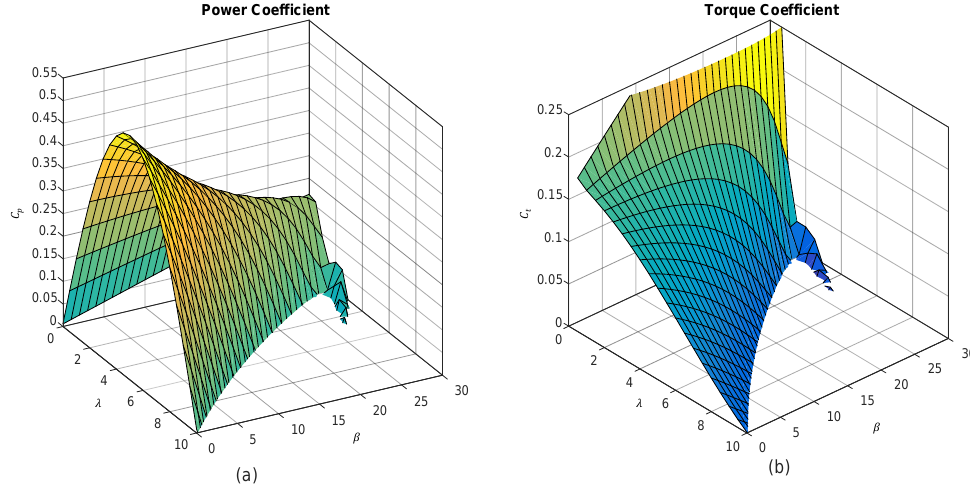
Figure 9. Coefficient proposed by Merahi, Mekhilef, and Madjid [29], with variations of 𝜆 and 𝛽 ; ( a ) power coefficient, ( b ) torque coefficient.